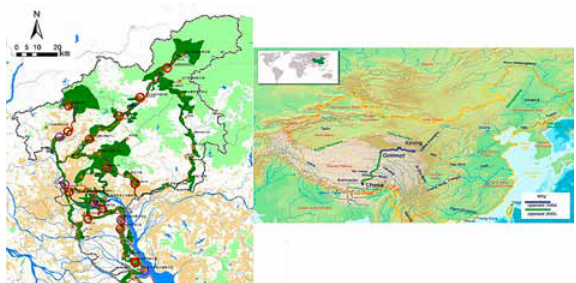
fig. 5. Map of Pearl river Delta regional Greenway (PrD, left) and Qinghai-Tibet railway (QTr, right) in China (Guangdong Provincial Department of Housing and urban-rural Deve- lopment and Tibet railway Bureau of